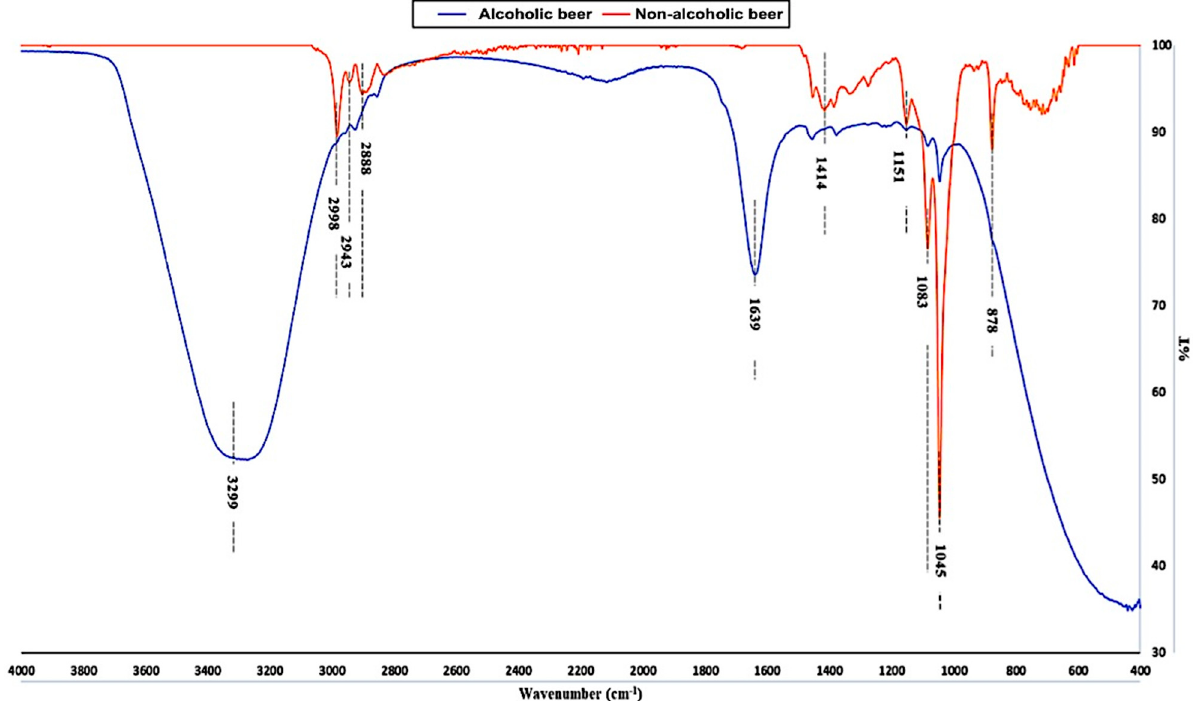
Figure 5. FTIR (Fourier transform infrared spectroscopy) spectra of alcoholic and non-alcoholic beer.